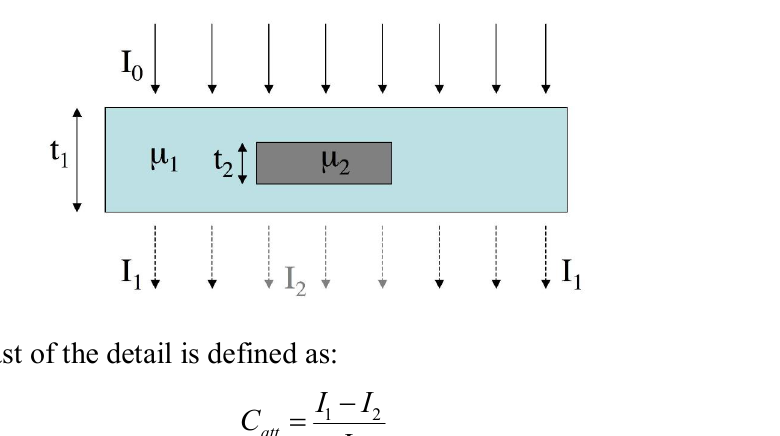
Figure 1. Working principle of conventional, attenuation-based x-ray imaging. The detail must stop (or deviate at an angle sufficiently large to take them out of the original beam) more (or less) x-rays than the surrounding background in order to be